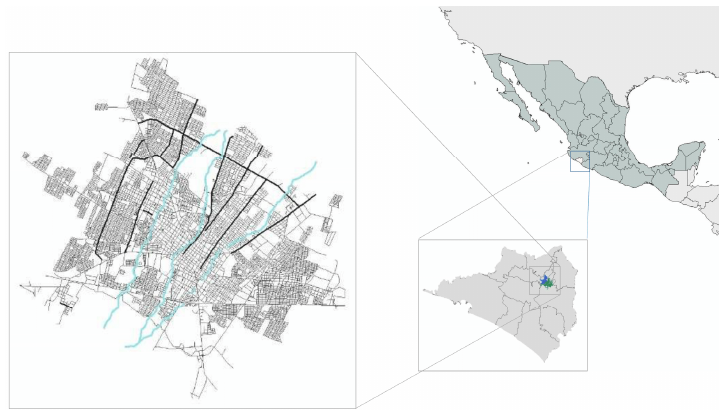
Figure 1. Colima-Villa de Álvarez urban zone.